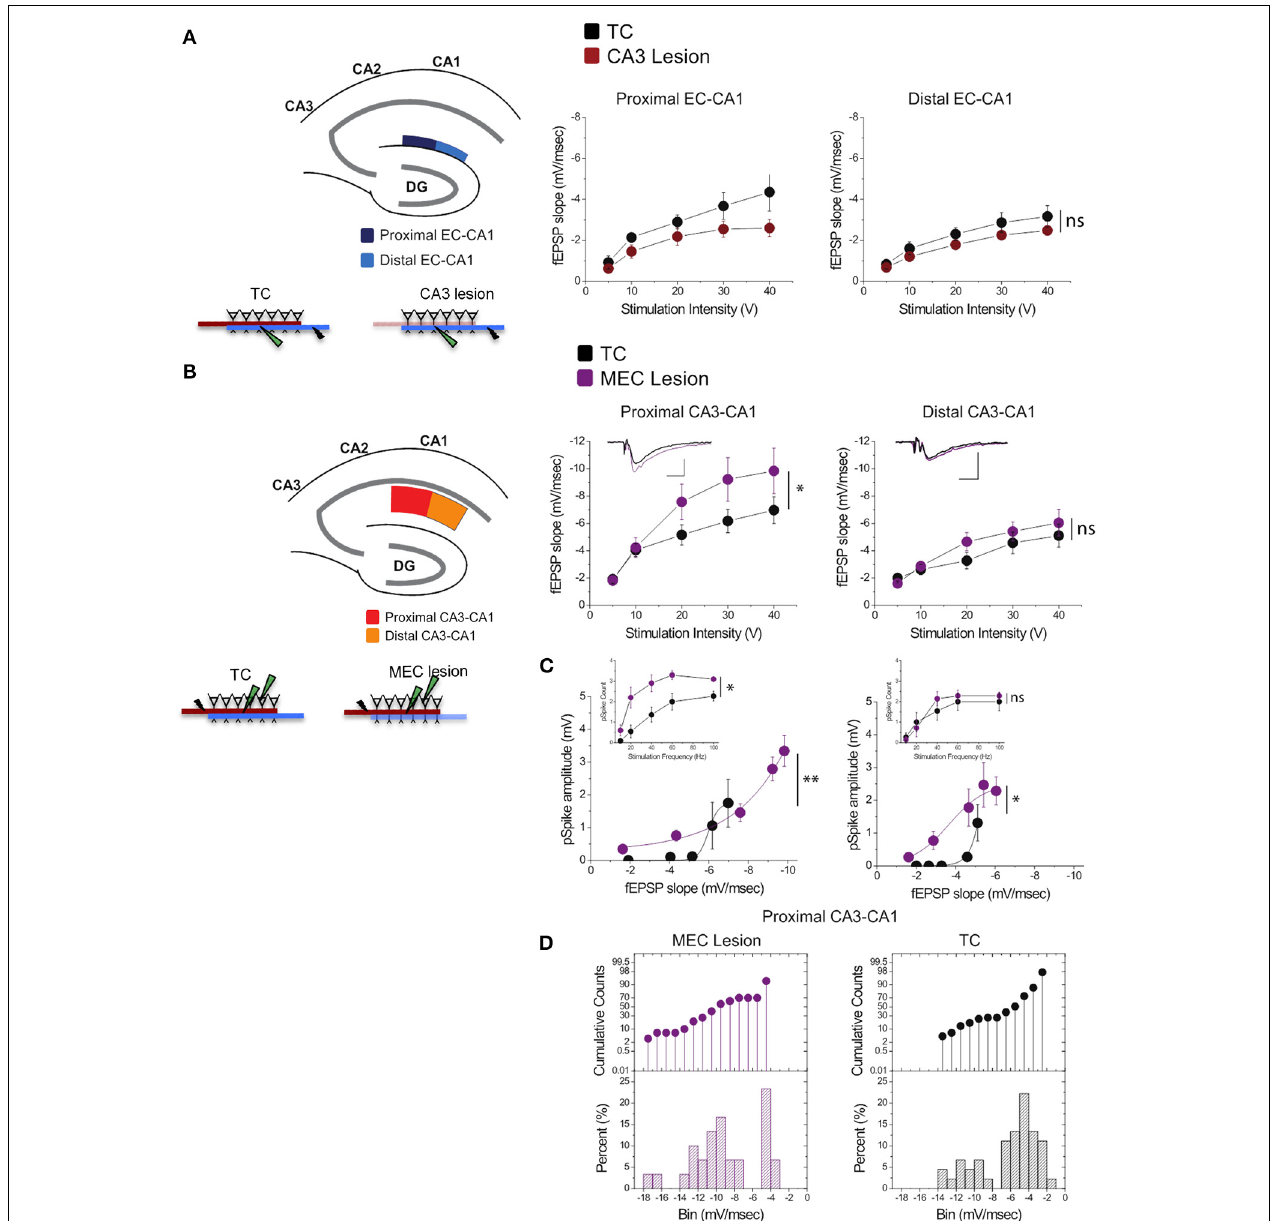
FIGURE 6 | MEC lesions selectively enhanced CA3-CA1 synaptic transmission. (A) CA3 lesions did not affect transmission in the MEC-CA1 pathway. In CA3 lesioned rats, stimulation and recording were performed in the proximal (dark blue) and distal (light blue) areas of the CA1 stratum lacunosum-moleculare, site of the EC-CA1 inputs The results showed no differences in synaptic transmission across all levels of stimulation between lesioned and TC groups. Data points represent mean ± s.e.m. (B) MEC lesions markedly increased CA1 synaptic responses ( ∗ ). Stimulation and fEPSP recording were performed in the proximal (red) and distal (orange) areas of the CA1 stratum radiatum (top panels). Compared to TC, MEC lesion rats showed a two-fold increase of synaptic responses at the proximal CA3-CA1 synaptic path and restricted increase in synaptic responses at the distal CA3-CA1 synaptic path. Inset: fEPSP traces (5mV, 5msec). Data points represent mean ± s.e.m. (C) The activity of CA1 neurons driven by synaptic responses evoked at the proximal CA3-CA1 path